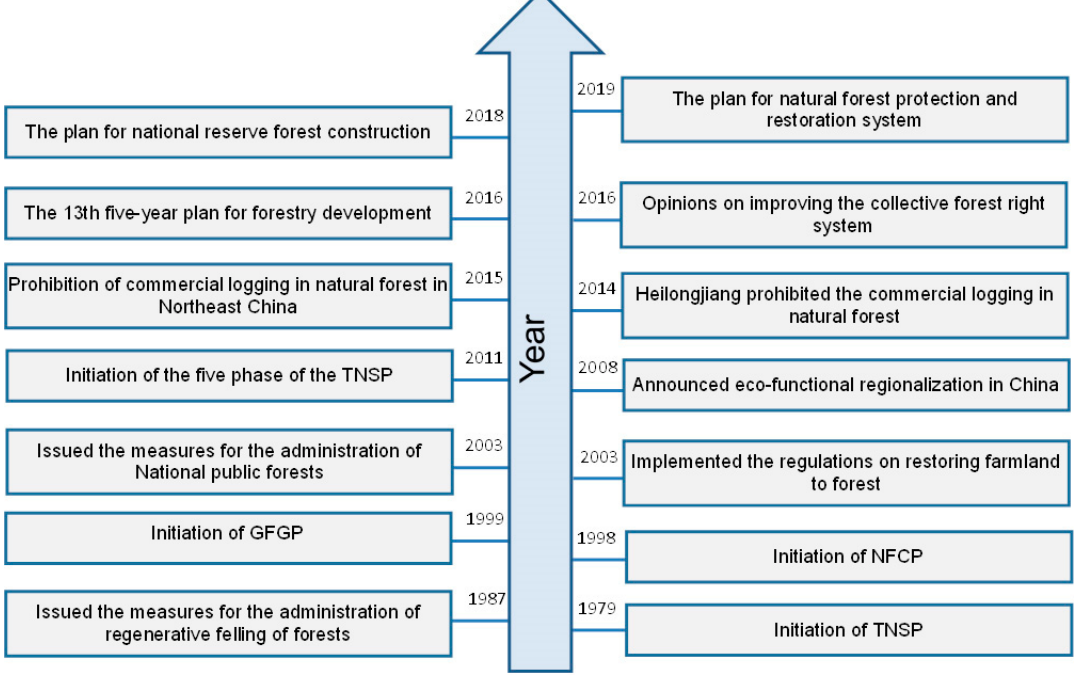
Figure 11. Government policies on forest conservation and management in northeast China.